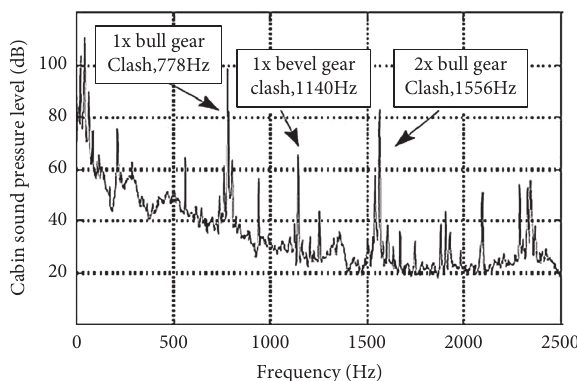
Figure 1: Interior noise spectrum of S-76 helicopter [4].